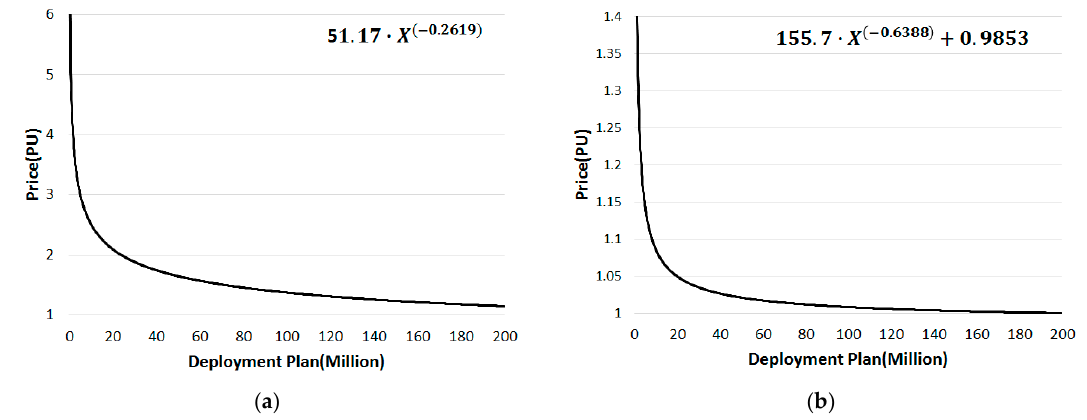
Figure 4. Communications Modem and DCU Cost Curve: ( a ) Communications Modem Cost Curve; ( b ) DCU Cost Curve. Table 2. Total Deployment Cost Result by Deployment Type (Billion